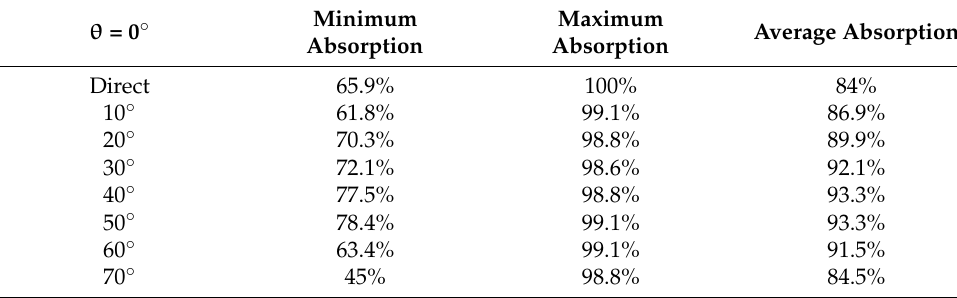
Figure 14. Absorption of the proposed optimized MMA structure for different incident angles. Table 4. Absorption for different values of incident angle.